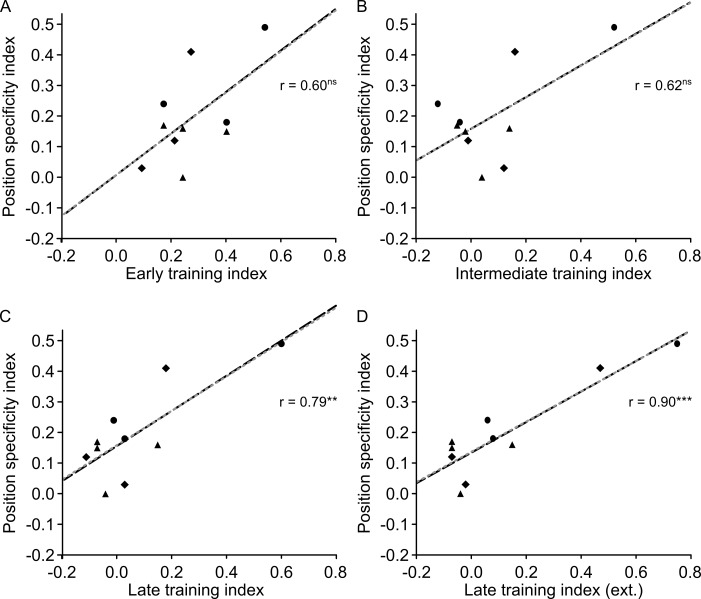
Scatterplot of position specificity and early (A), intermediate (B), and late training indices either based on 60 thresholds learning data (C) or on additional asymptotic data for participants P2-4 and P8-10 (D). The black dashed line results from an ordinary least square regression (r also obtained form that analysis), whereas the grey dotted line was fitted with betas obtained by using robust regression. Different symbols represent different training schemes: triangle = 15 sessions with 4 staircases, circle = 10 sessions with 8staircases, diamond = 15 sessions with 4 staircases plus 3 refresher sessions. * p < .050, ** p < .010, *** p < .005.